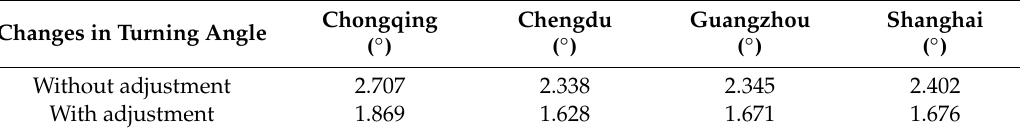
Table 3. The average changes in the azimuth angle in the spatial directional relationship.